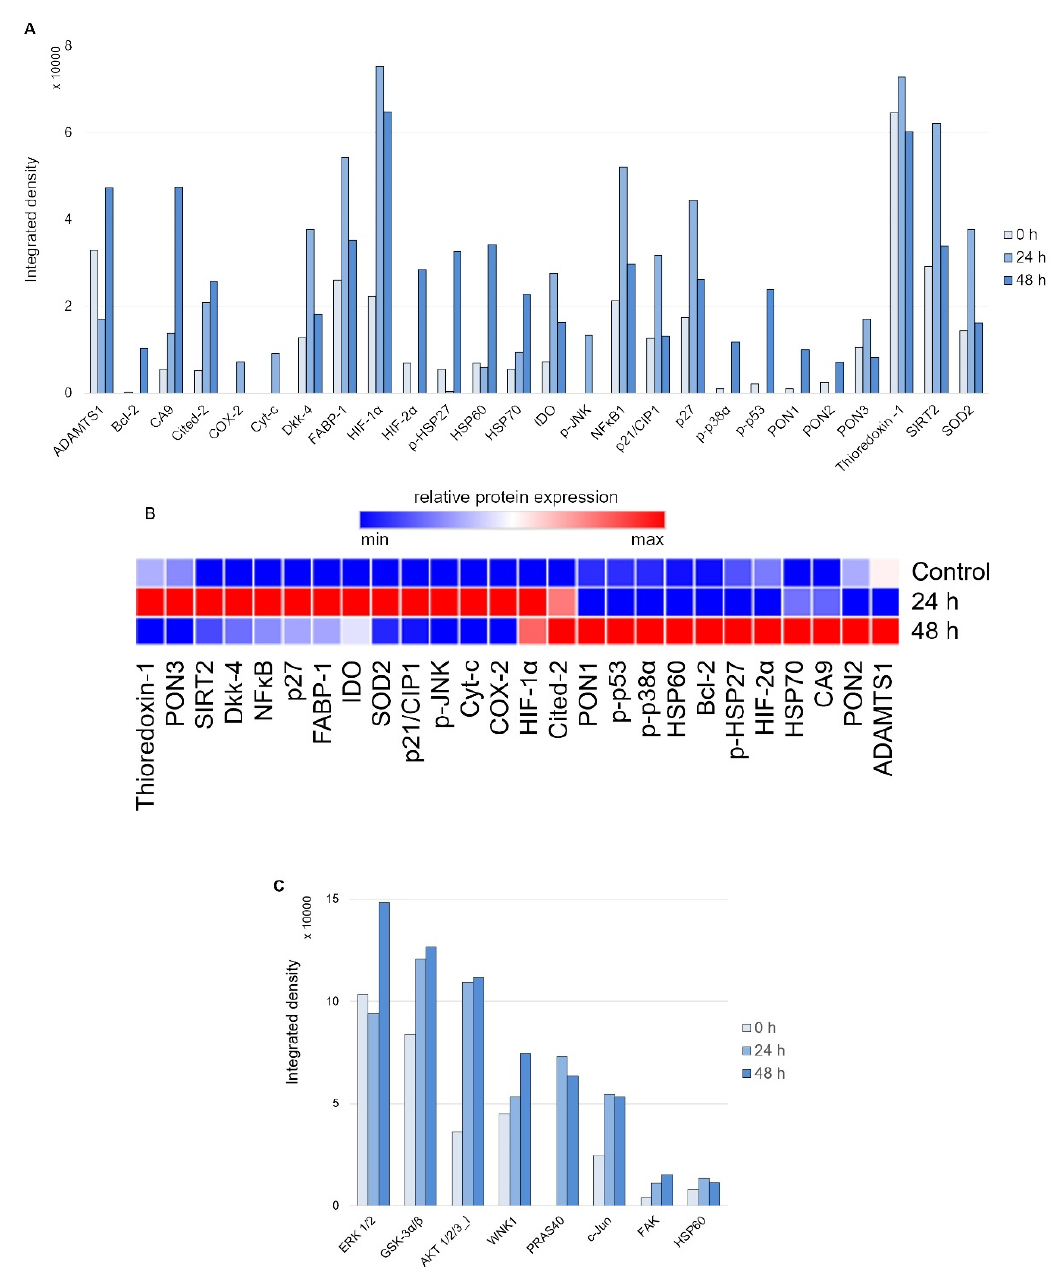
Figure 5. Array profiling of stress response proteins and kinase phosphorylation in response to DpC in the SH-SY5Y cell line. ( A ) Stress response protein profile of cells treated with 20 μ M DpC for 24 and 48 h. ( B ) Hierarchical clustering of relative stress protein expression. ( C ) Phospho-kinase protein profile of cells treated with 20 μ M DpC for 24 and 48 h.